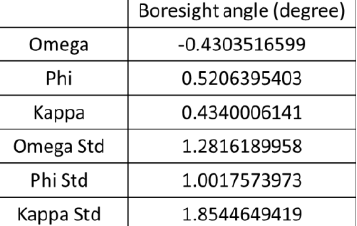
Table 3. Boresight angle calibration